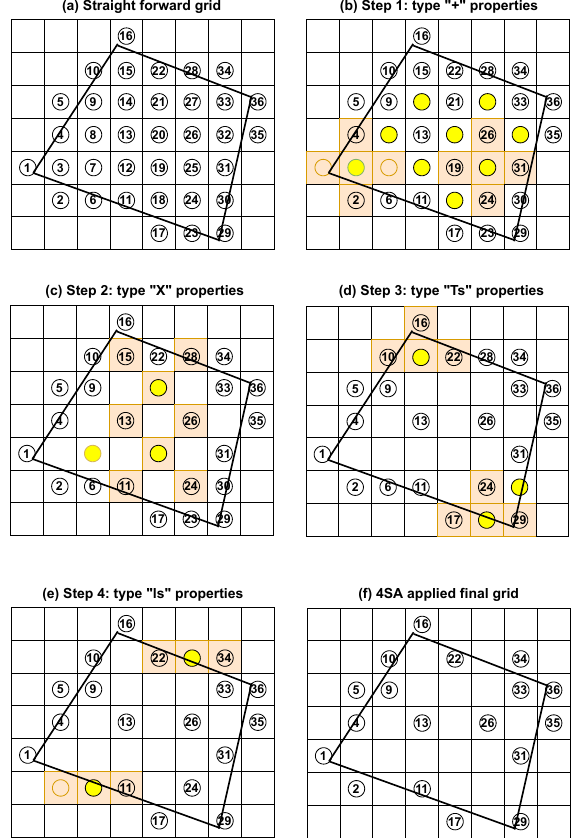
Figure 5. Application of 4SA on real-world RSID adopting an SFC-based grid cell space translates into indexing SC types. The 9 grid cells that satisfy type “+” SCs are